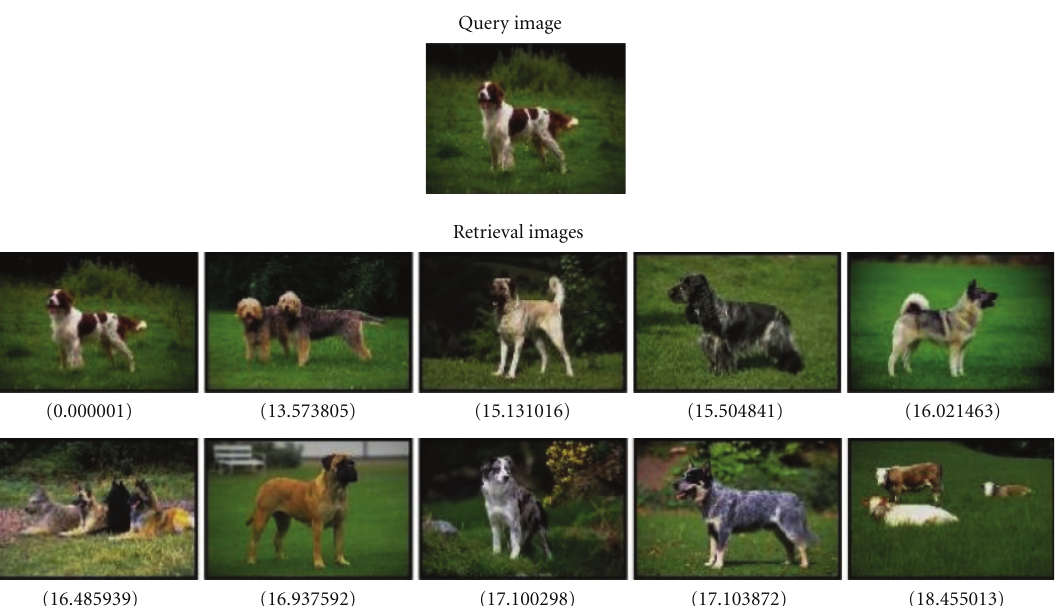
Figure 4: Sample of retrieved results using the EMD.